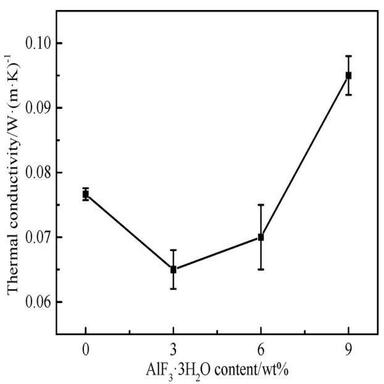
Effect of the AlF3⋅3H2O content on the heat conductivity of lightweight porous materials.